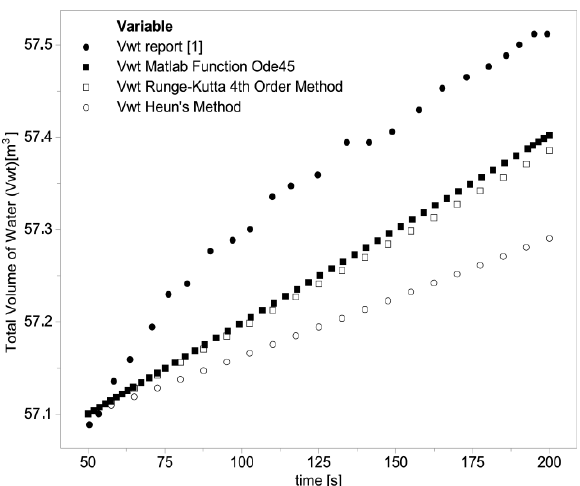
Figure 10. Behavior of the total volume of water with the different solution method (Ode45, Runge – Kutta, Heun).